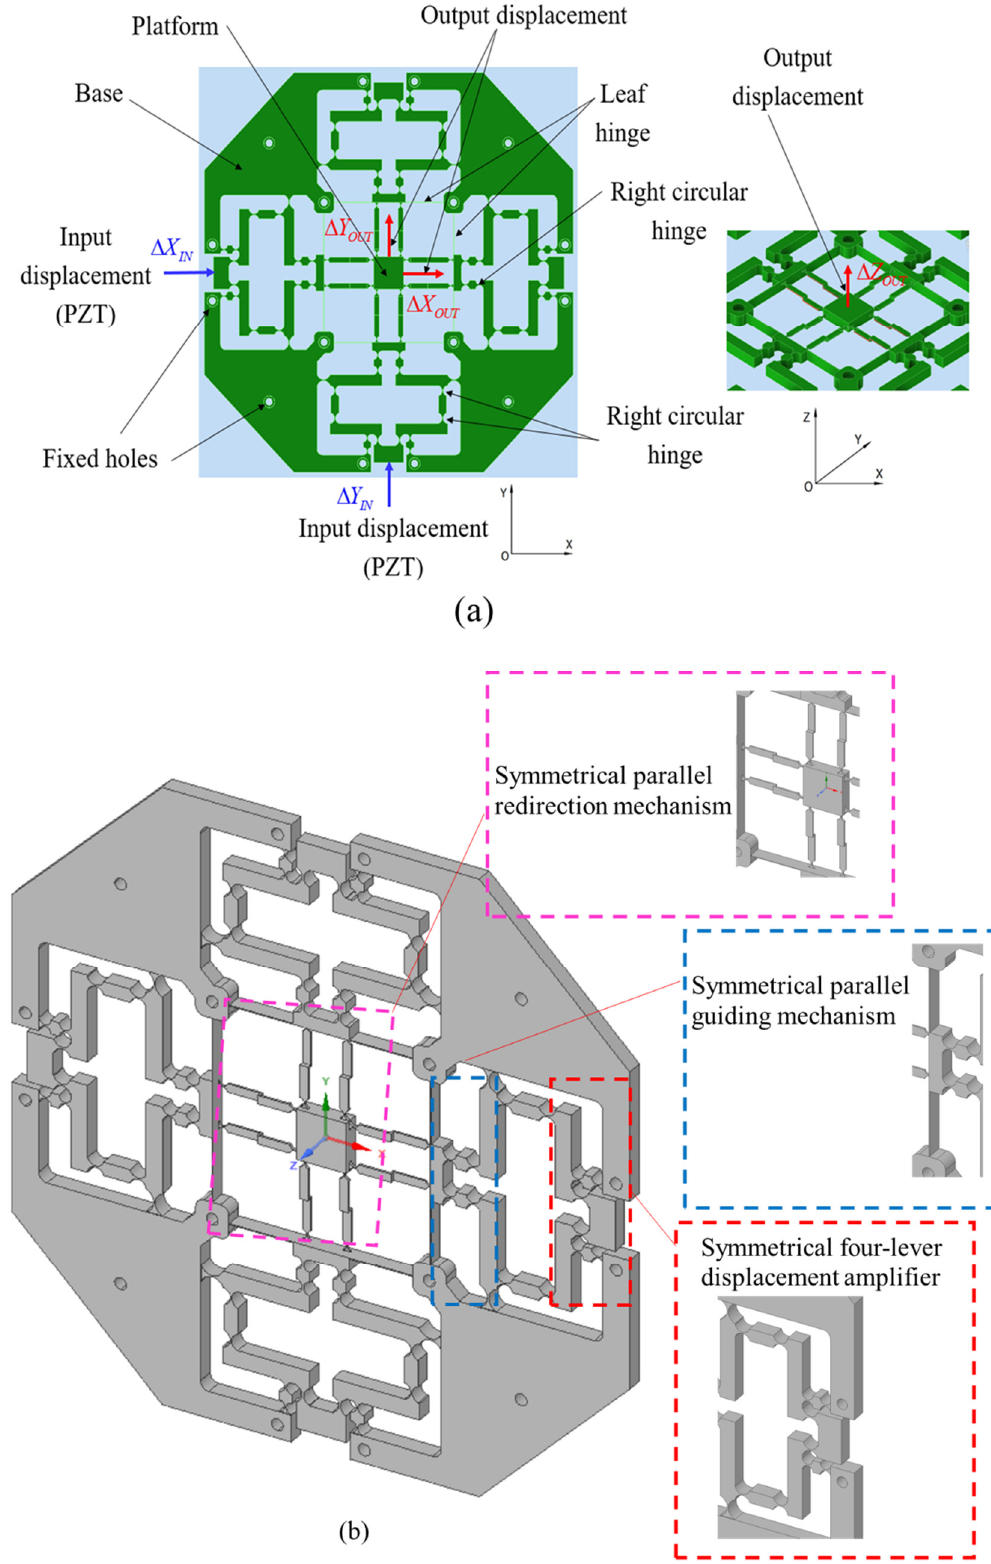
Figure 2. Design diagram of XYZ micropositioner: ( a ) design schematic and ( b ) detailed parts.